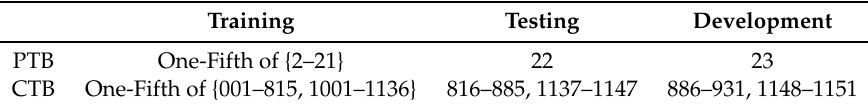
Table 2. The data split for training, testing and